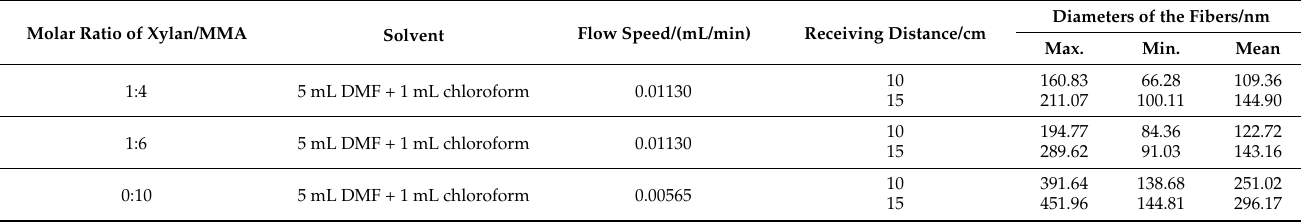
Table 4. The effect of receiving distance on diameters of the electrospun